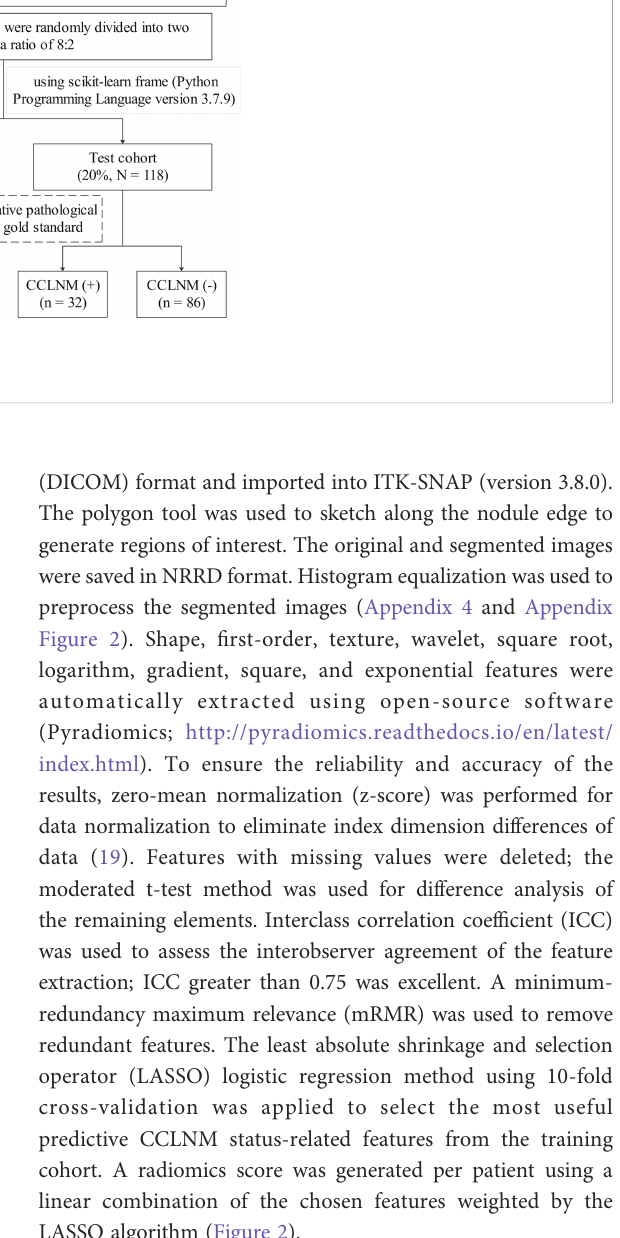
Figure 1. Ultrasound parameters included diameter, location (right lobe, left lobe, or isthmus), composition (mixed or solid), echogenicity (hyper/isoechoic, hypoechoic, or very hypoechoic), shape (wider-than-tall or taller-than-wide), margin (smooth, ill- de fi ned, or lobulated/irregular), calci fi cation (none, macrocalci fi cation, rim calci fi cation, or microcalci fi cation), vascularization, and capsular invasion.